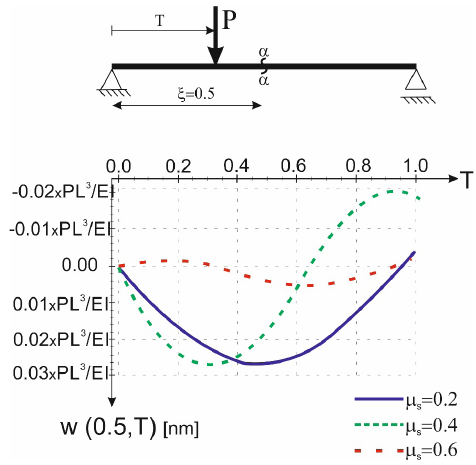
Figure 13: Strain gradient model. Vibrations of the beam in the middle cross-section